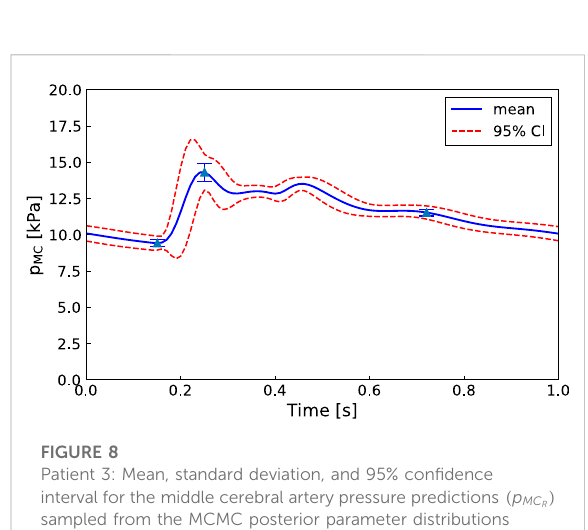
FIGURE 7 Patient 1: Mean, standard deviation, and 95% con fi dence interval for the right middle cerebral artery pressure predictions ) sampled from the MCMC posterior parameter distributions ( p MC R (100 samples).